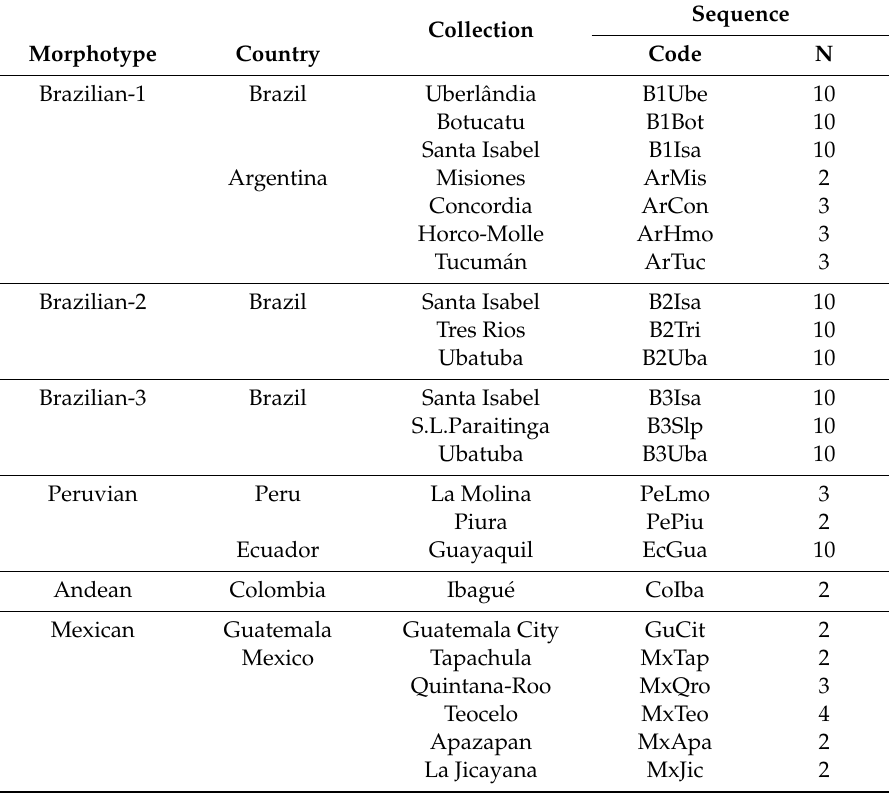
Table 3. Collection sites, codes, and number of ITS1 sequences by morphotype and country.